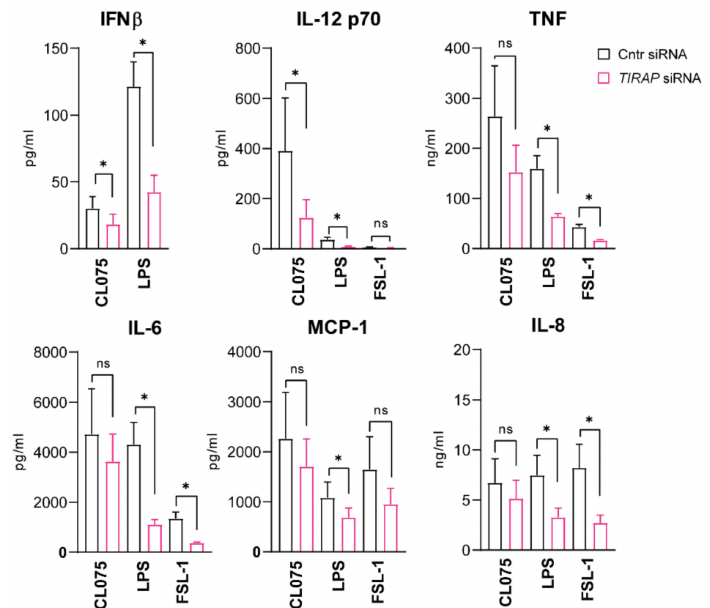
Figure 2. TIRAP silencing significantly inhibits TLR8-mediated IFN β and IL12 p70 secretion by primary human macrophages. IFN β and TNF secretion in 6–8 consecutive experiments with cells from different donors were analyzed by specific ELISA kits, with other cytokines’ secretion addressed by BioPlex assays. Statistical significance evaluated using Wilcoxon matched-pairs signed-rank test, presented as mean with SD, significance levels—* p < 0.05,